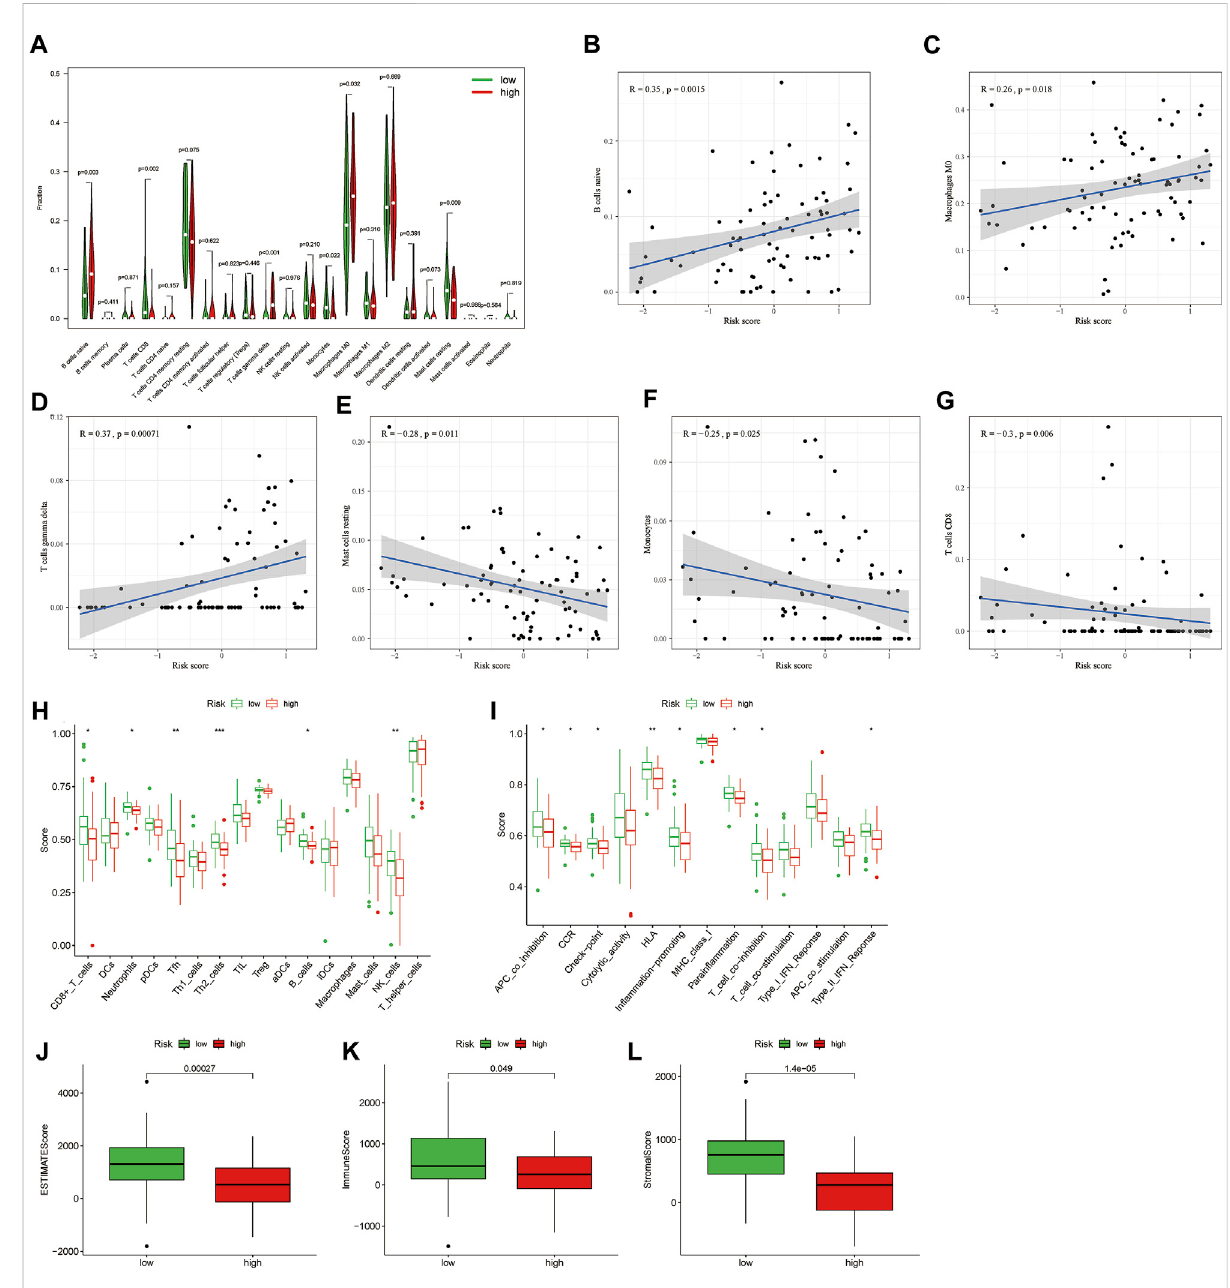
Difference of tumour immune microenvironment between high-risk and low-risk groups. (A) The differential in fi ltration of tumour immune cells between high-risk and low-risk groups. (B – G) The correlation between riskscore with immunecell types, including B cells naive, macrophages M0 and T cells gamma delta, mast cell resting, monocyte and CD8 T cell. (H) The immune cell bubble of risk groups. (I,J) Single-sample gene set enrichment analysis of immune status between low-risk and high-risk groups. (K – M) The difference of tumor immune microenvironment (ESTMATE, immune, and stromal score) between high-risk and low-risk